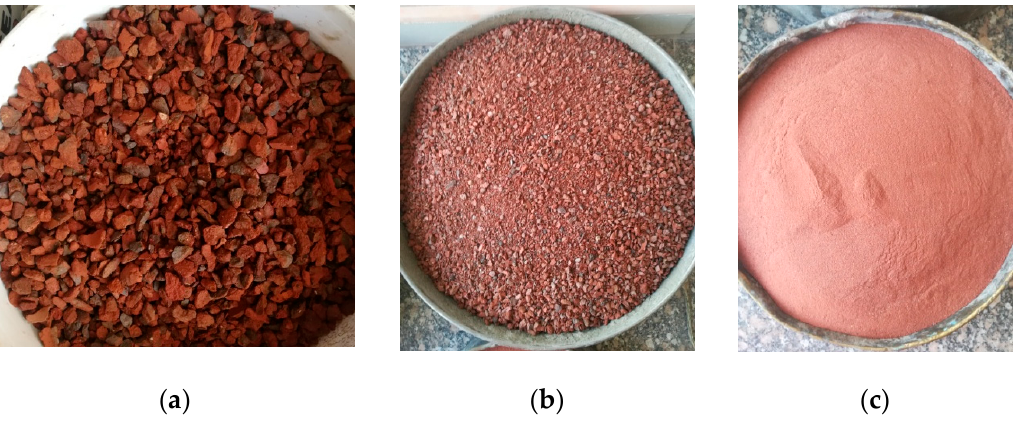
Figure 1. Crushed clay brick aggregate: ( a ) CCB ( b ), FCB, and ( c ) CBP. Table 2. Oxide compositions of the used materials.